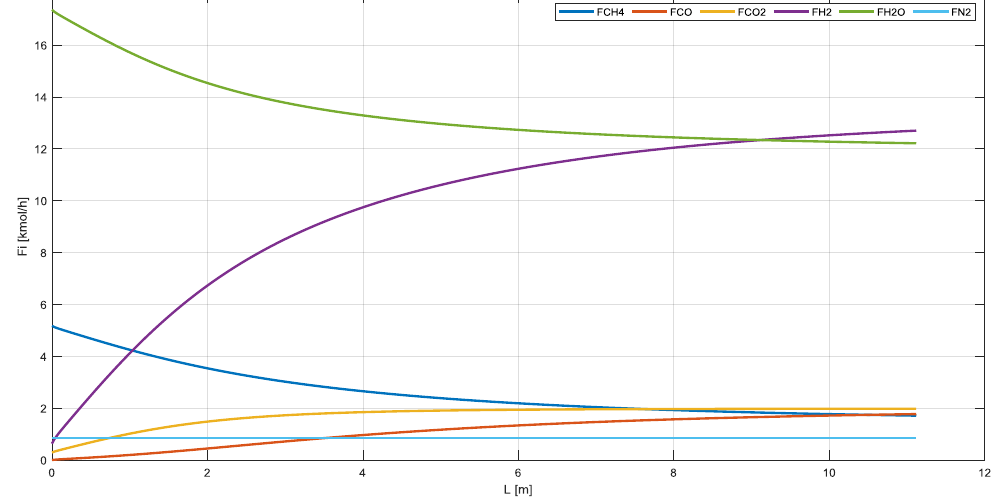
Figure 10. Gas flowrate in SR.